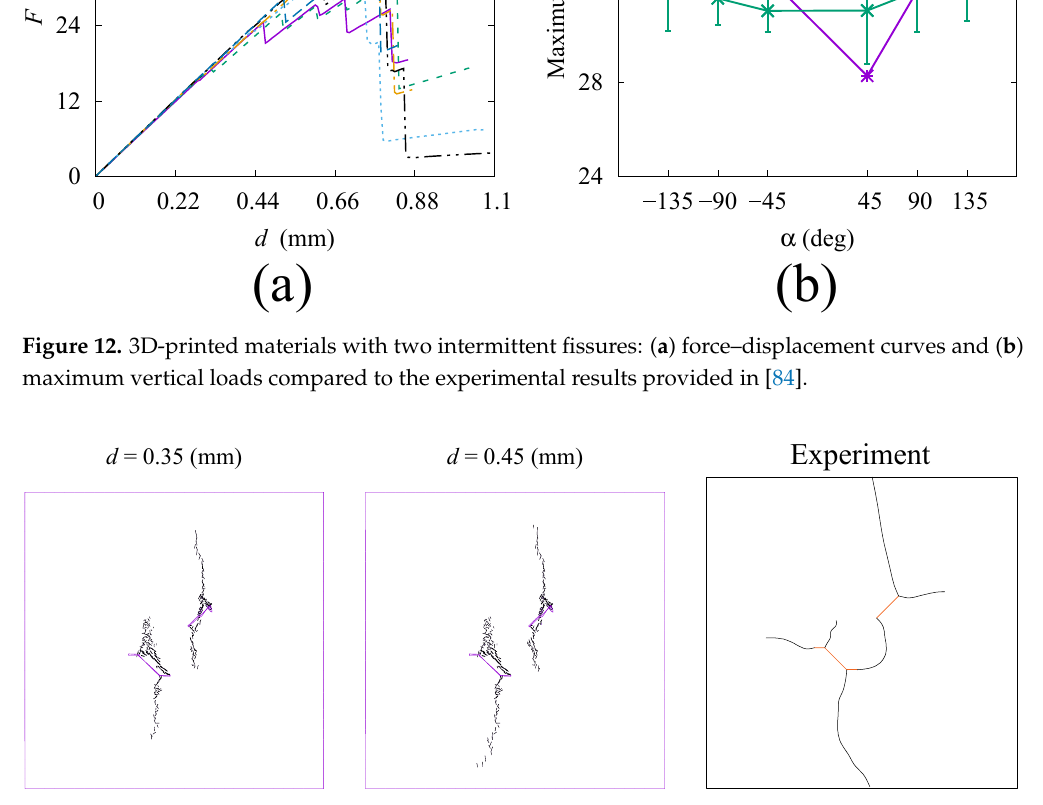
Figure 13. 3D-printed materials with two intermittent fissures ( α = 45 ◦ ): the crack opening plots (deformation scale 1:1) compared to the experimental results provided in